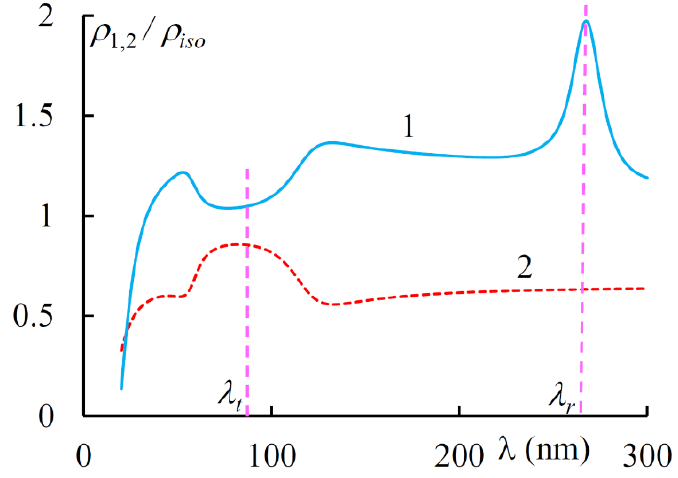
Figure 8. The spectra of PDS for the two EPs at g = 0.3.